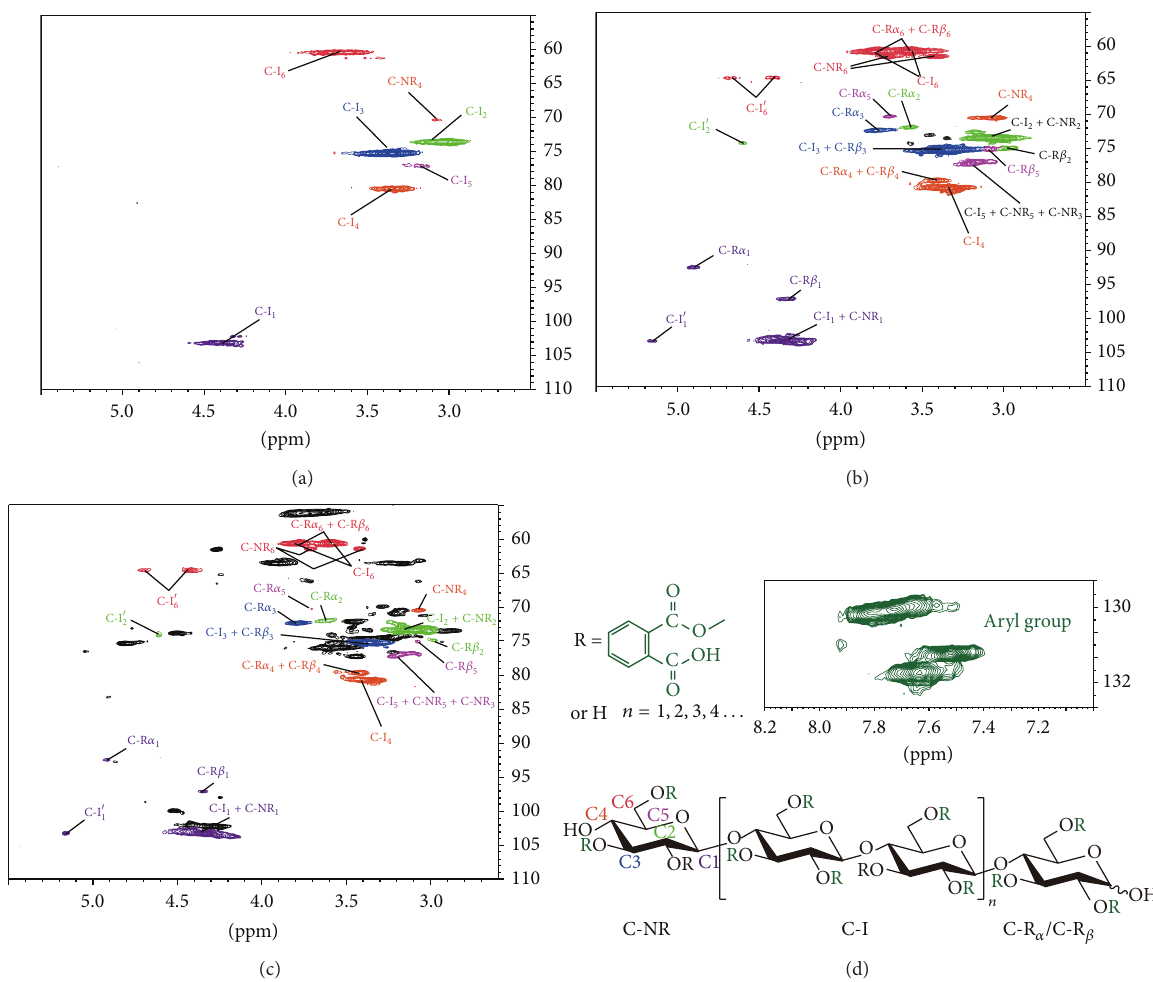
Figure 4: 2D HSQC NMR spectra of unmodified cellulose (C0, spectrum a), phthalated cellulose (C5, spectra b and d), and phthalated bagasse (S5, spectrum c). Table 2: Primary NMR correlations in DMSO- 𝑑 6 for cellulose modified with phthalic anhydride. Glycosyl